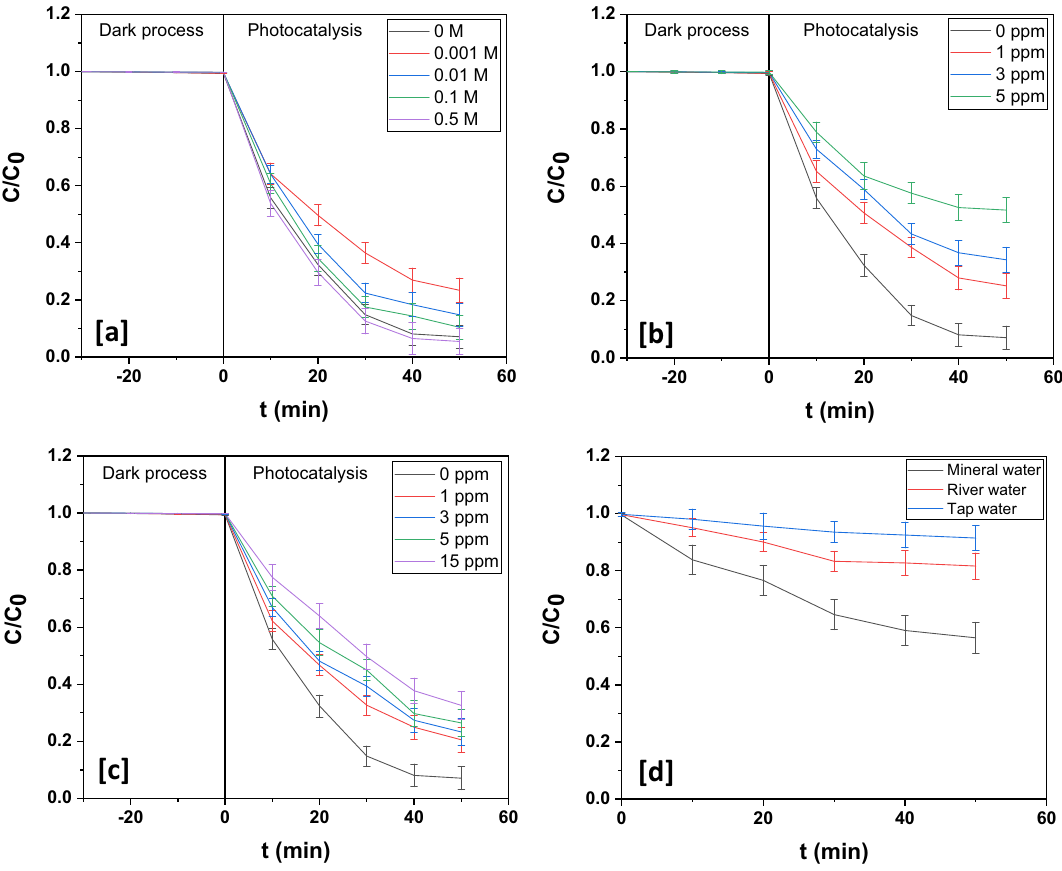
Figure 16. Photodegradation dynamic curves of esomeprazole photodegradation in presence of different concentrations of ( a ) acetone, ( b ) HAS and ( c ) SDS over In 2 O 3 /MoS 2 /Fe 3 O 4 . Photodegradation dynamic curves of esomeprazole photodegradation in different water matrices over In 2 O 3 /MoS 2 /Fe 3 O 4